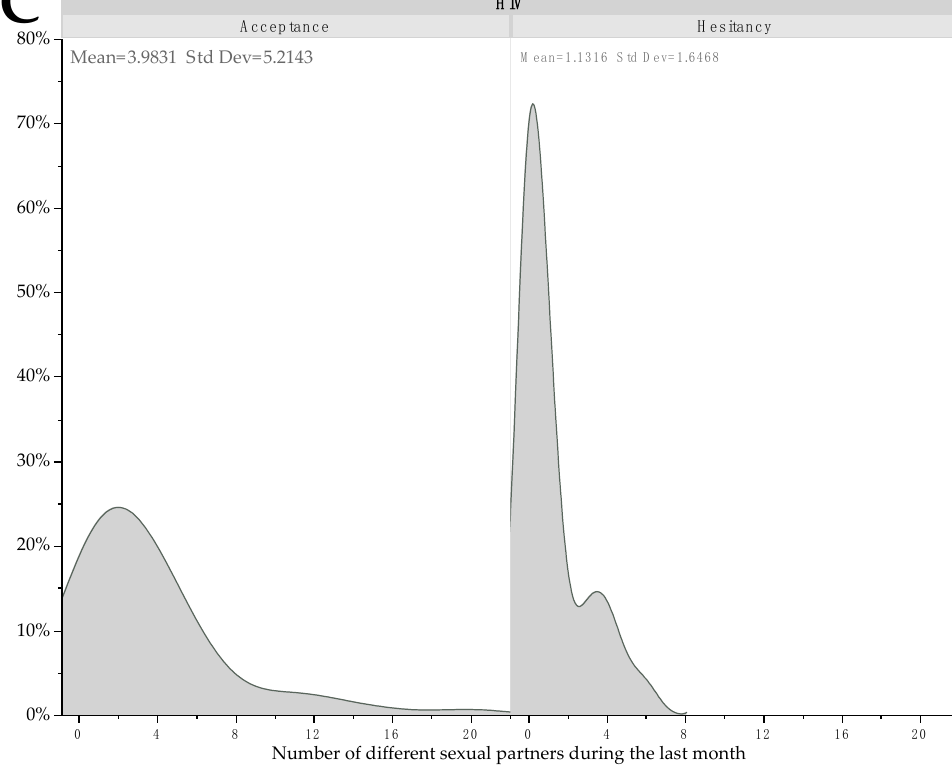
fected by MPXV (45.5% vs. 83.3%, p = 0.032). Fewer of them felt that the smallpox vaccine